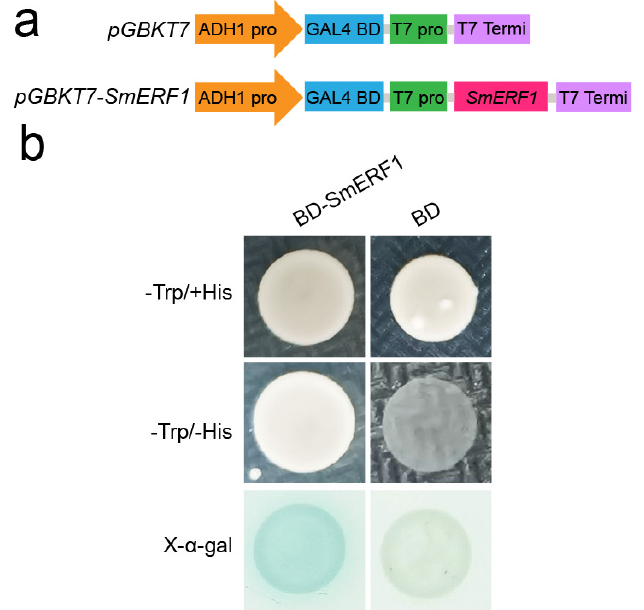
Figure 6. Transcriptional activation activity assay of SmERF1 using the yeast GAL4 system. ( a ) Diagram of pGBKY7 and the recombinant pGBKT7- SmERF1 vector. ( b ) Growth of yeast cells transformed with the pGBKT7 empty vector or recombinant pGBKT7 − SmERF1 on a medium supplemented with X − α − Gal but lacking His and Trp. Blue color indicates the activation of the transcriptional activity. BD, binding domain.